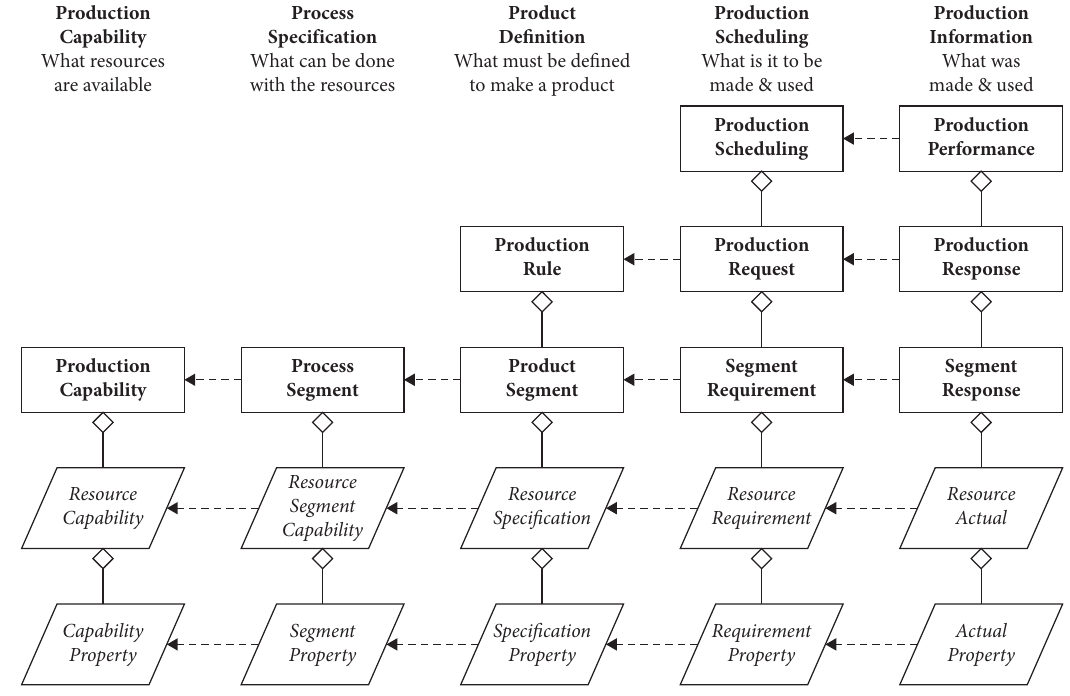
Figure 4: The IEC 62264 hierarchy model (IEC 62264) [31].